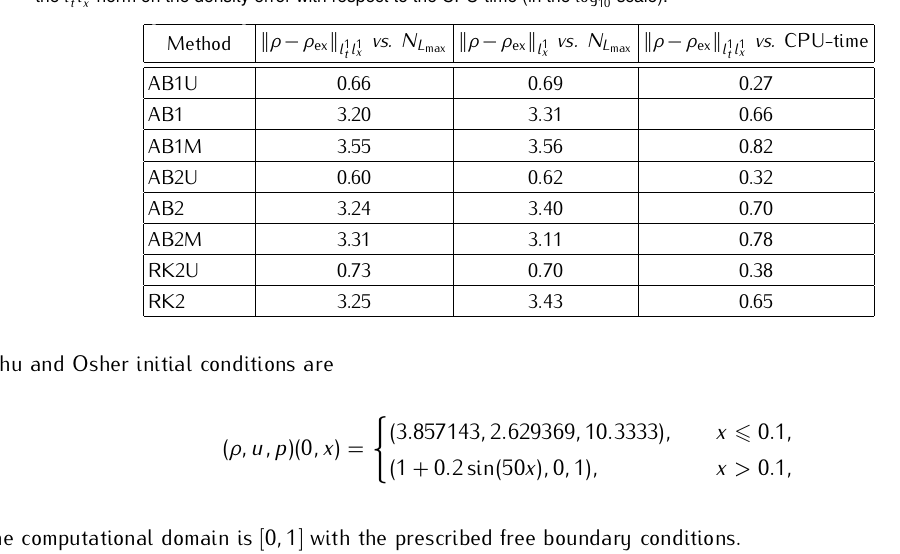
1 1 t l x -norm and l x -norm at time t = 0 . 13 with respect to the averaged number of cells, and